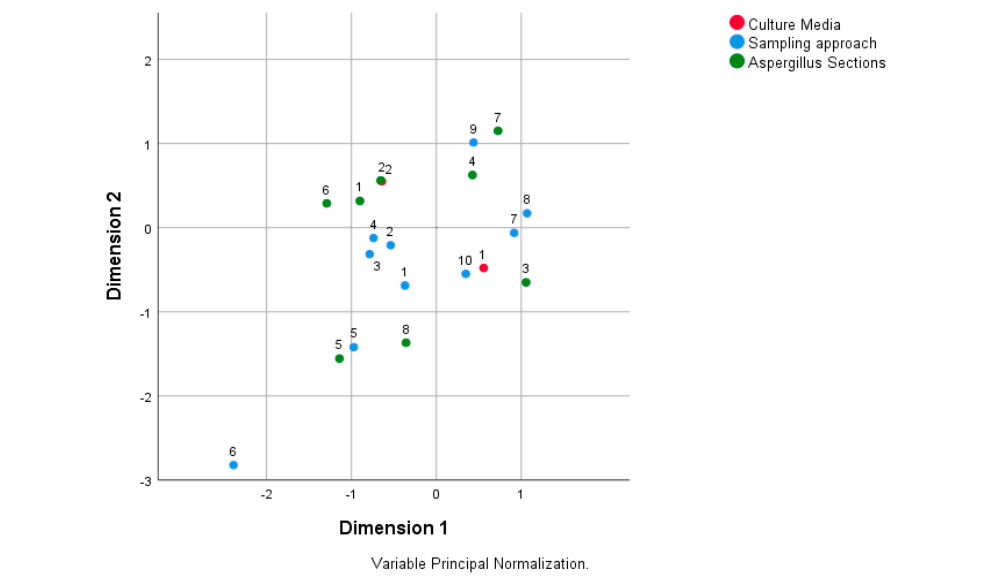
Figure 1. Joint plot of category points for Aspergillus sections, culture media, and indoor environment. Figure 2. Joint plot of category points for Aspergillus sections, culture media, and sampling approach